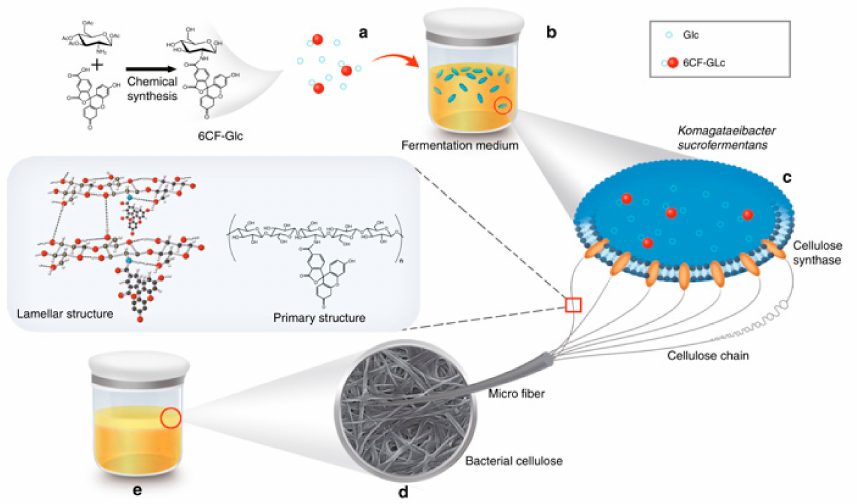
Figure 5. Synthesis of 6CF-BC by in situ microbial fermentation method, using glucose (Glc) modified with 6CF as a carbon source for K. sucrofermentans fermentation. ( a ) Glc and 6CF-Glc molecules; ( b ) microorganism fermentation; ( c ) the synthesis of 6CF-BC fibers through K. sucrofermentans , ( d ) microstructure of 6CF-BC; ( e ) the 6CF-BC pellicle obtained through microorganism fermentation. Reproduced from [65], with permission from Nature Communications,